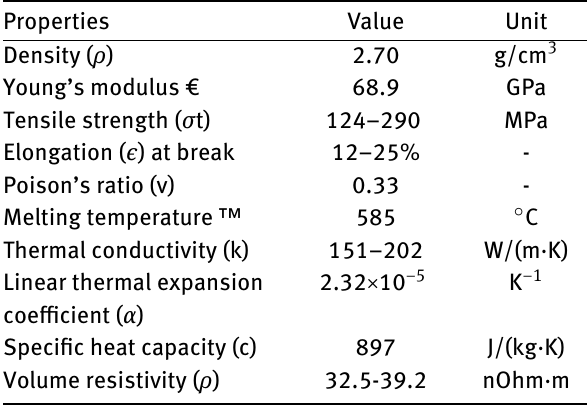
Table 1: Physical, mechanical, thermal and electrical properties of AL-6061